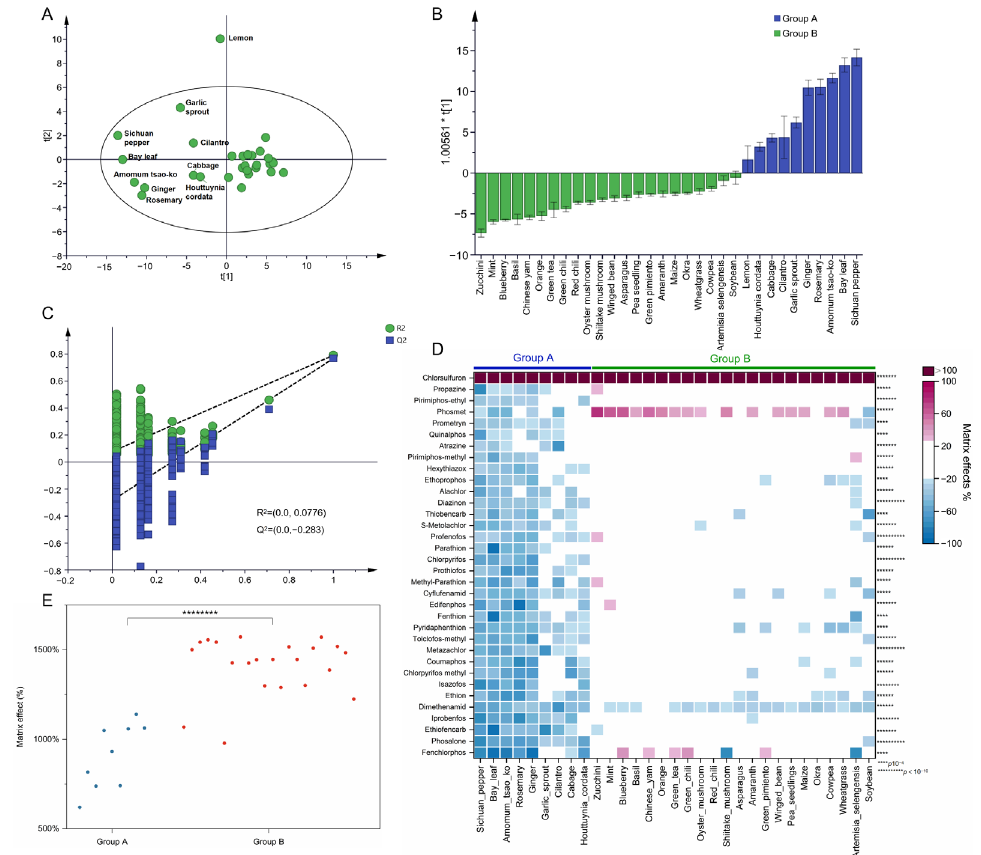
Figure 5. ( A ) The score plot of PCA modeling; ( B ) the score plot of OPLS-DA modeling between groups A and B; ( C ) the permutation test result (500 times); ( D ) the heatmap of MEs for 34 differential pesticides between groups A and B; ( E ) distribution of MEs on chlorsulfuron between groups A and B, and 4 to 10 asterisks (**** to **********) indicated significant difference ( p < 10 − 4 to p < 10 − 10 ). Lemon was removed, according to the initial PCA result, and OPLS-DA was used to screen out differential pesticides contributing to ME variations between groups A and B.